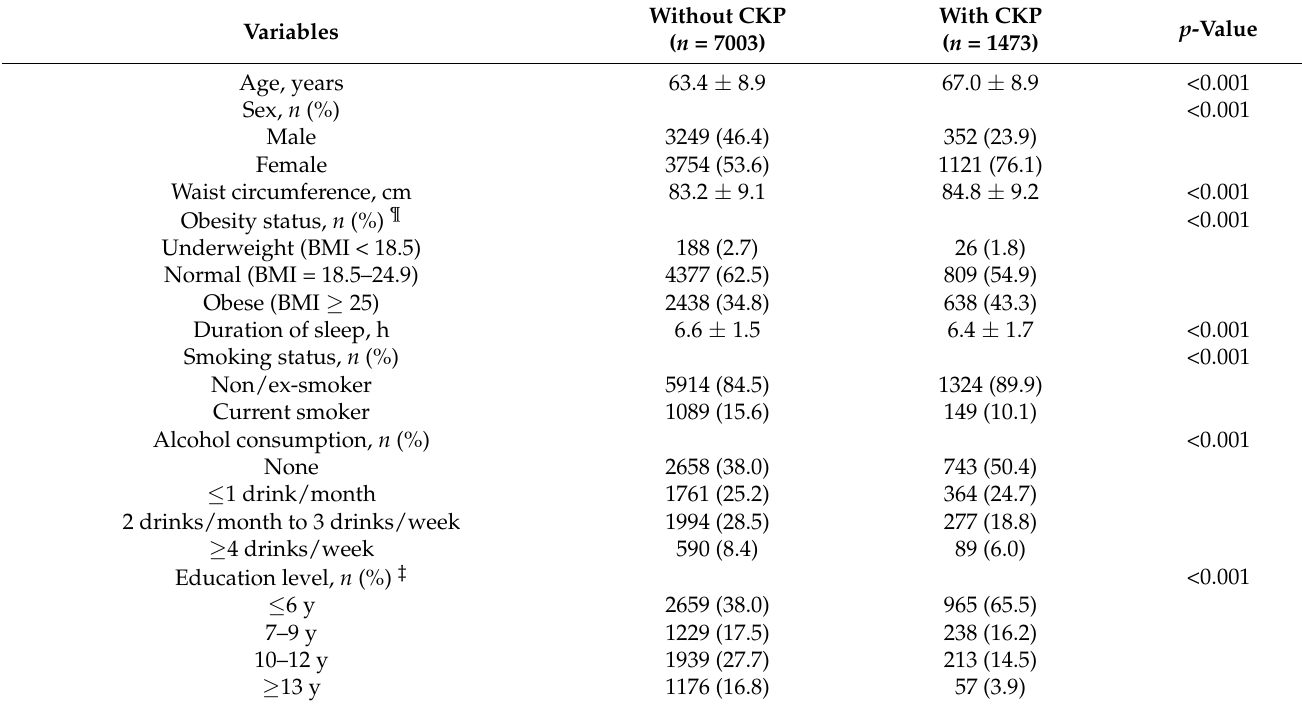
Table 1. General characteristics of the study subjects according to presence of CKP.